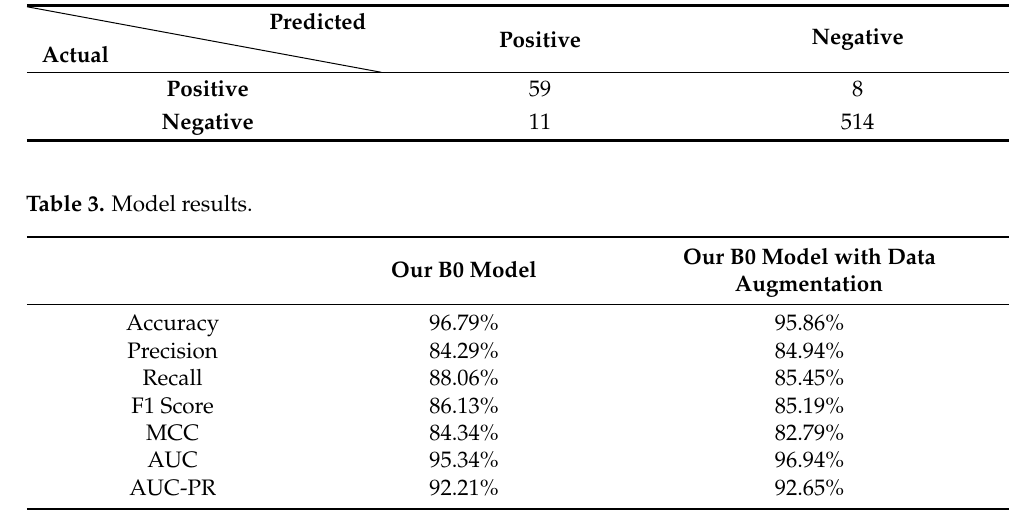
Table 2. Confusion matrix.